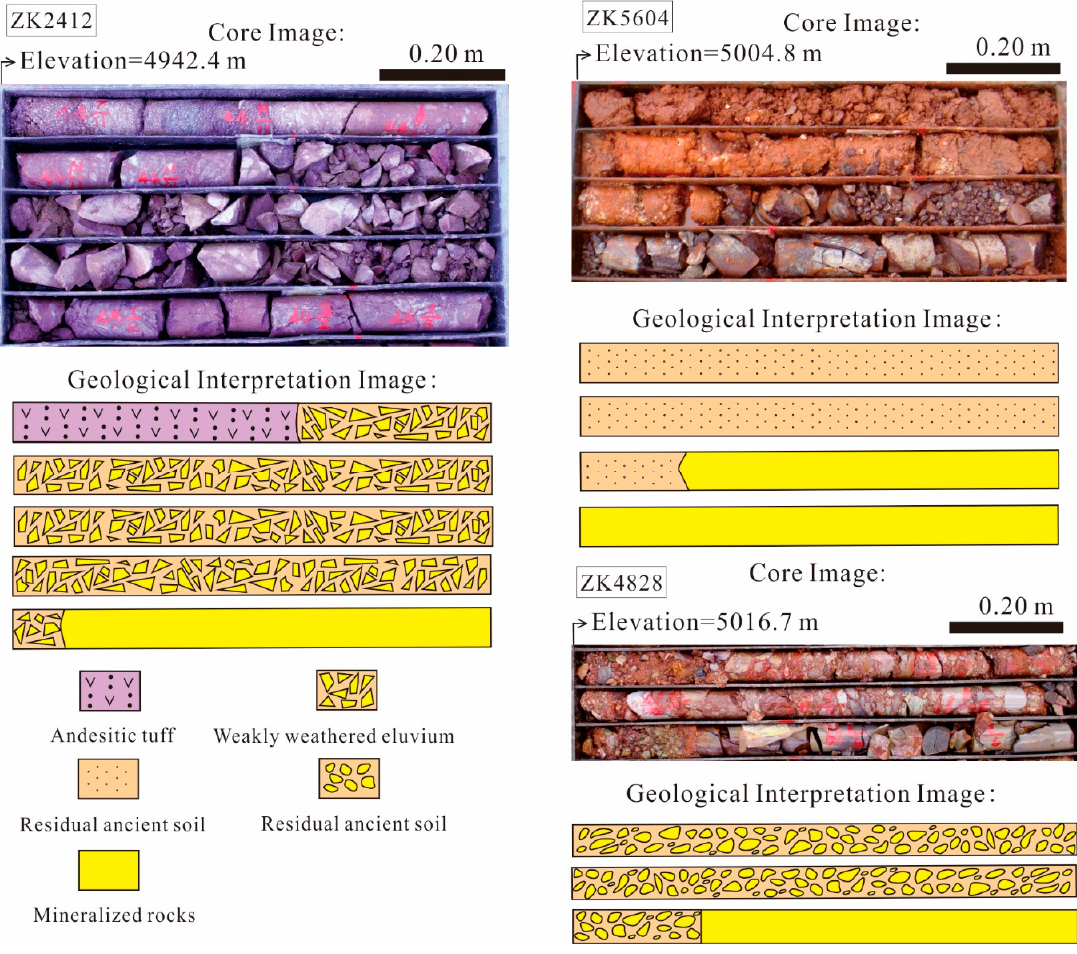
Figure 8. Photographs of typical weathering paleo-crusts in the Tiegelongnan deposit. ZK2412—The first type weathering weakly weathered eluvium. ZK5604—The second type weathering residual